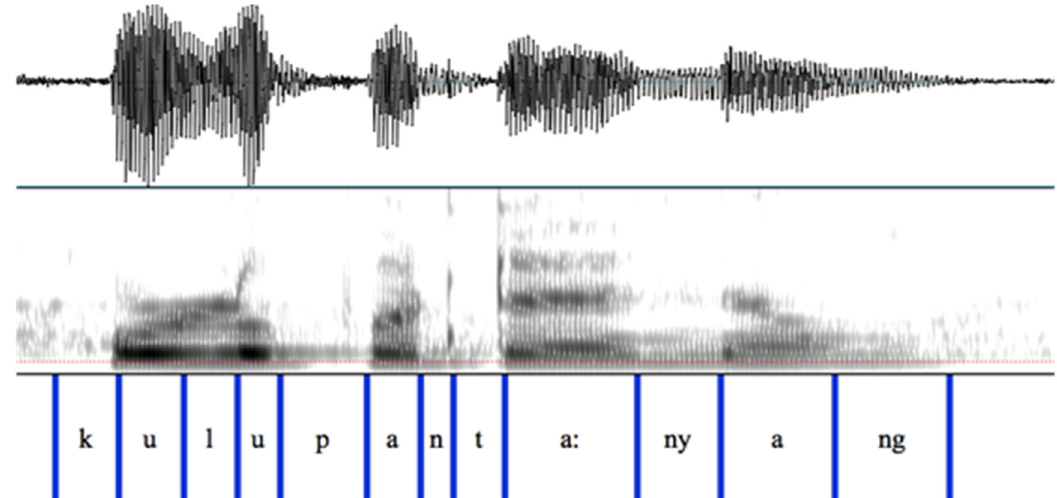
Figure 9. Realization of nasal when present. Above the line, vowel produced. Below the line, vowel not produced. Pre- stopping is not indicated here. Colors refer to individual speakers, ordered youngest to oldest, left to right.